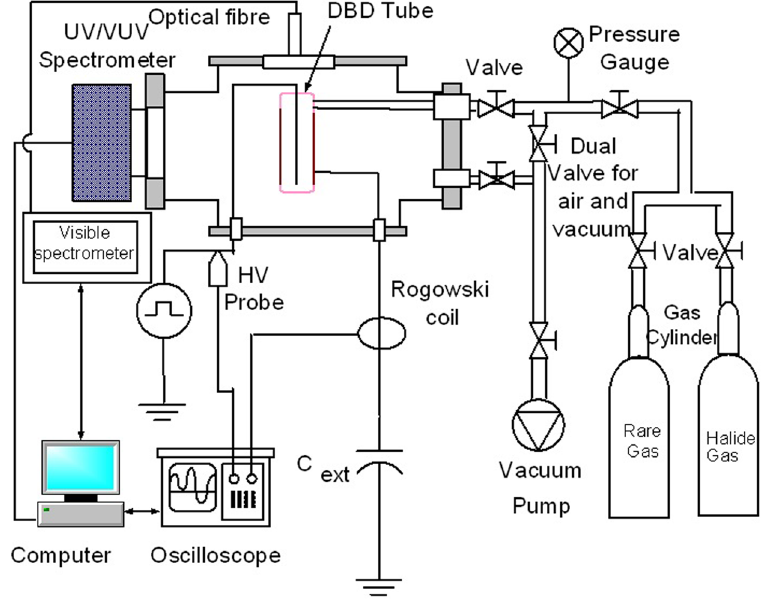
Figure 2. Electrical and spectroscopic characterization setup for